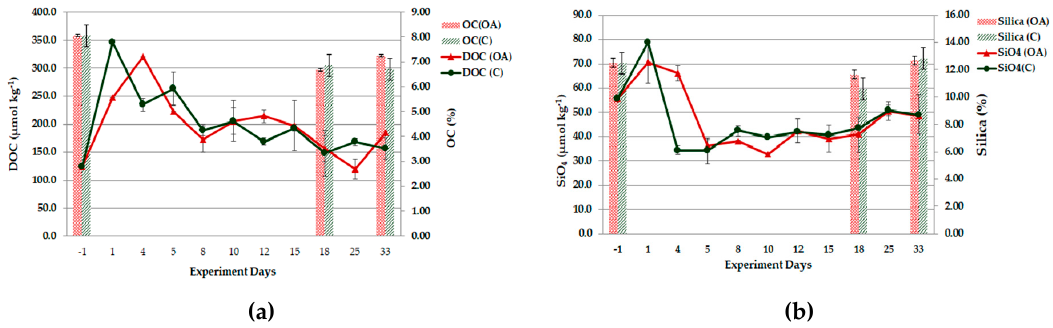
Figure 10. DOC concentrations (in µ mol kg − 1 ) and sedimentary OC (in %; ( a )); silicate (in µ mol kg − 1 ) and sedimentary silica (in %; ( b )) for the duration of the experiment for OA and C conditions (x-axis: days of the experiment; mean values and standard deviations for the two replicates of each treatment).